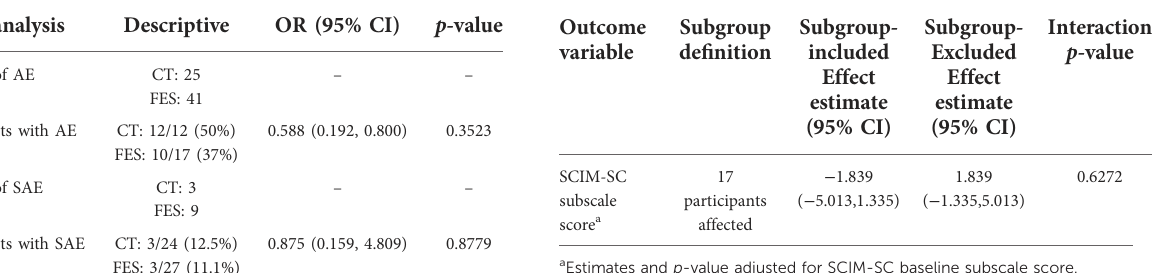
TABLE 9 Adverse events.